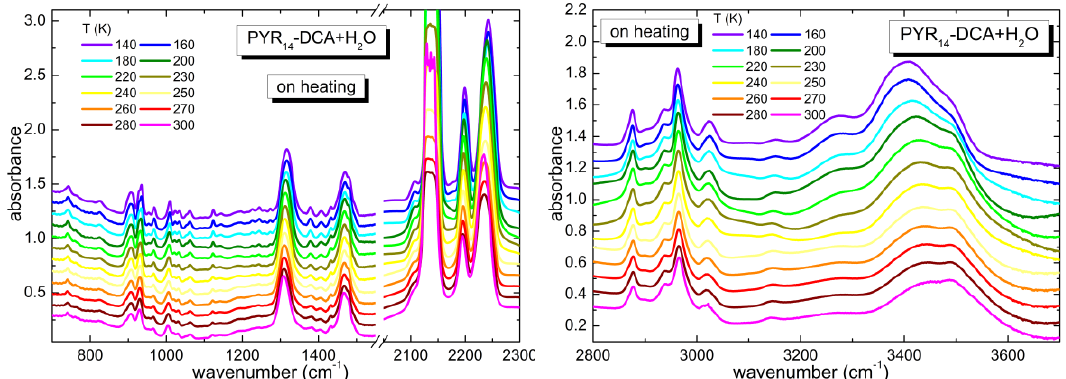
Figure 6. Temperature dependence of the spectra of PYR 14 -DCA+H 2 O measured on heating from 140 up to 300K in different frequency regions (700–1550 and 2050–2300cm −1 in the left panel and 2800–3700cm −1 in the right panel).